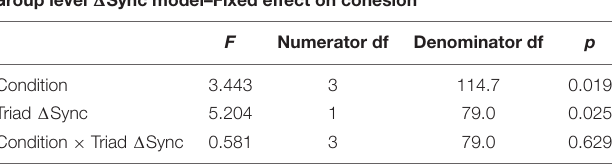
TABLE 6 | A mixed model (see equation above) predicting participant’s cohesion from (cid:49) Sync ( γ 10 ), task condition ( γ 20 ), and their interaction ( γ 12 ) at the triad level. Group level (cid:49) Sync model–Fixed effect on cohesion